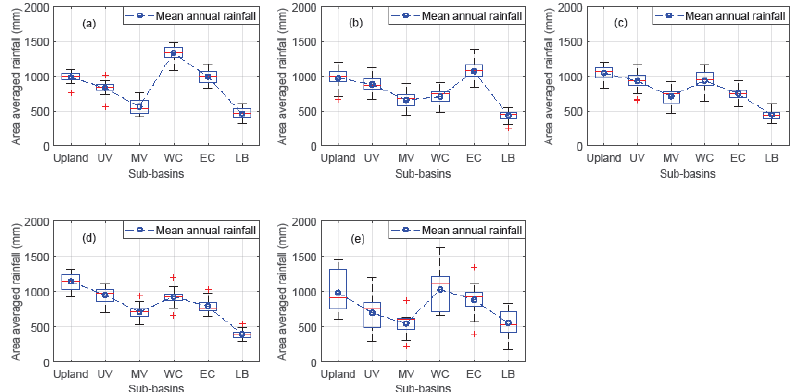
Figure 4. Box plot showing the median, quantile, and range of annual area-averaged rainfall: ( a ) observed rainfall, ( b ) PERSIANN-CDR, ( c ) TRMM 3B43v7, ( d ) IMERG, ( e ) GSMap_NRT. The red plus signs (+) are the outliers of areal average rainfall in sub-basins. UV: upper valley; MV: middle valley; WH: western highland catchment; EC: eastern catchment; LB: lower basin. Table 2. Statistics of the annual area-weighted rainfall of the ARB.